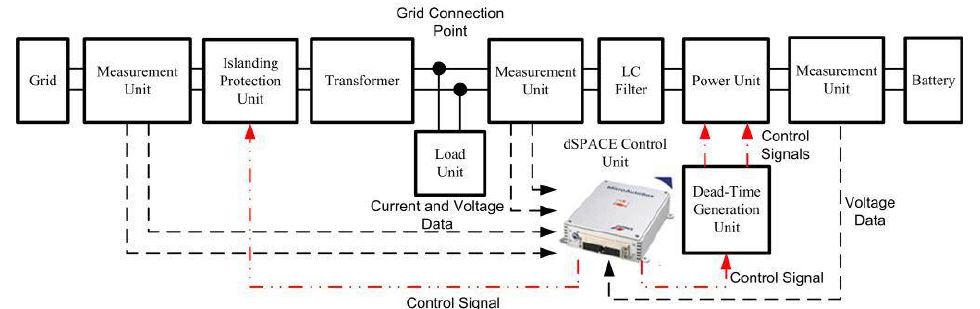
Figure 6. General scheme of the test platform. Table 2. Parameters of the test platform.